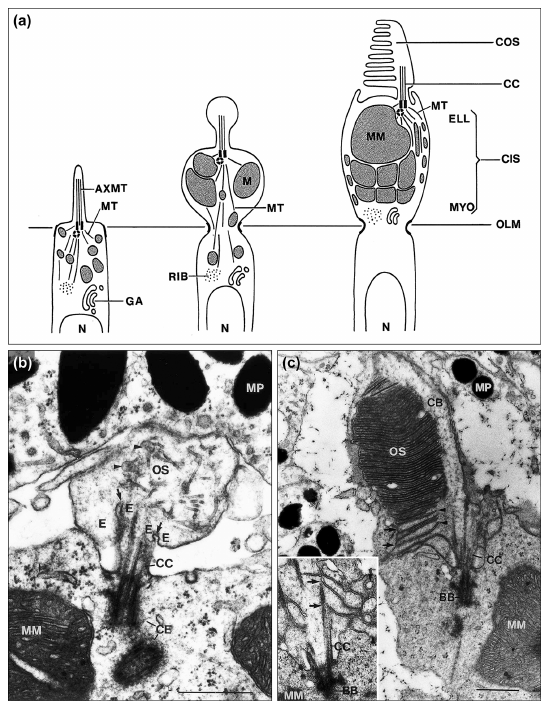
Figure 3. Development of retinal cones in Tupaia belangeri . (a) Inner segment mitochondria. Embryonic day 32 (left scheme): small supranuclear mitochondria are attached to cytoplasmic mi- crotubules (MT). The primitive cilium (AXMT, axonemal micro- tubules) projects beyond the outer limiting membrane (OLM). 12- day-old Tupaia (middle scheme): the developing inner segment ex- tends beyond the OLM. MTs originate from centrally located cen- trioles and guide individually growing mitochondria into the inner segment. In the adult (right scheme), all inner segment mitochondria including megamitochondria (MM) reside in the ellipsoid (ELL). The connecting cilium (CC) links the cone outer segment (COS) to the cone inner segment (CIS). Note that centrioles and CC are shifting from central to excentric positions. GA, Golgi apparatus; MYO, myoid; N, nuclei; RIB, ribosomes. (b–c) Disk formation, transmission electron micrographs (longitudinal sections). In the 12-day-old Tupaia (b) , evaginations (E) of the plasma membrane have formed at the base of the immature outer segment (OS) that contains tubulovesicular material (arrowhead). Next to the connect- ing cilium (CC), the membranes of adjacent evaginations are joined in the initial disk rims (arrows). CE, centrioles; MP, melanin gran- ules. In the 17-day-old Tupaia (c) , plenty of nearly mature disks are aligned at the ciliary backbone (CB) of the outer segment. Note initial disk rims (arrowheads) as well as evaginations (arrows) of the plasma membrane that project from the inner face of the cil- ium. Inset: obliquely sectioned basal outer segment: “the initial disk rims are hooked (arrows) to the axonemal microtubules”. BB, basal body of the connecting cilium. Scale bars = 0.5µm. Figure 3a is re- produced from Knabe and Kuhn (1996b), Fig. 5, by permission of John Wiley & Sons, Inc. Fig. 3b, c is reproduced from Knabe and Kuhn (1998, Figs. 2, 4). © Springer-Verlag 1998, with kind permis- sion from Springer Science and Business